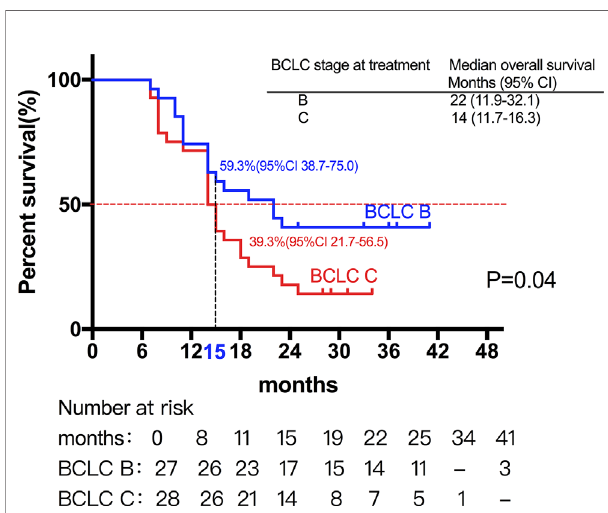
FIGURE 2 | Median OS of patients with different stage. A total of 27 patients classi fi ed as BCLC stage B had a median OS of 22 months, while 28 patients classi fi ed as BCLC stage C had a median OS of 14 months.